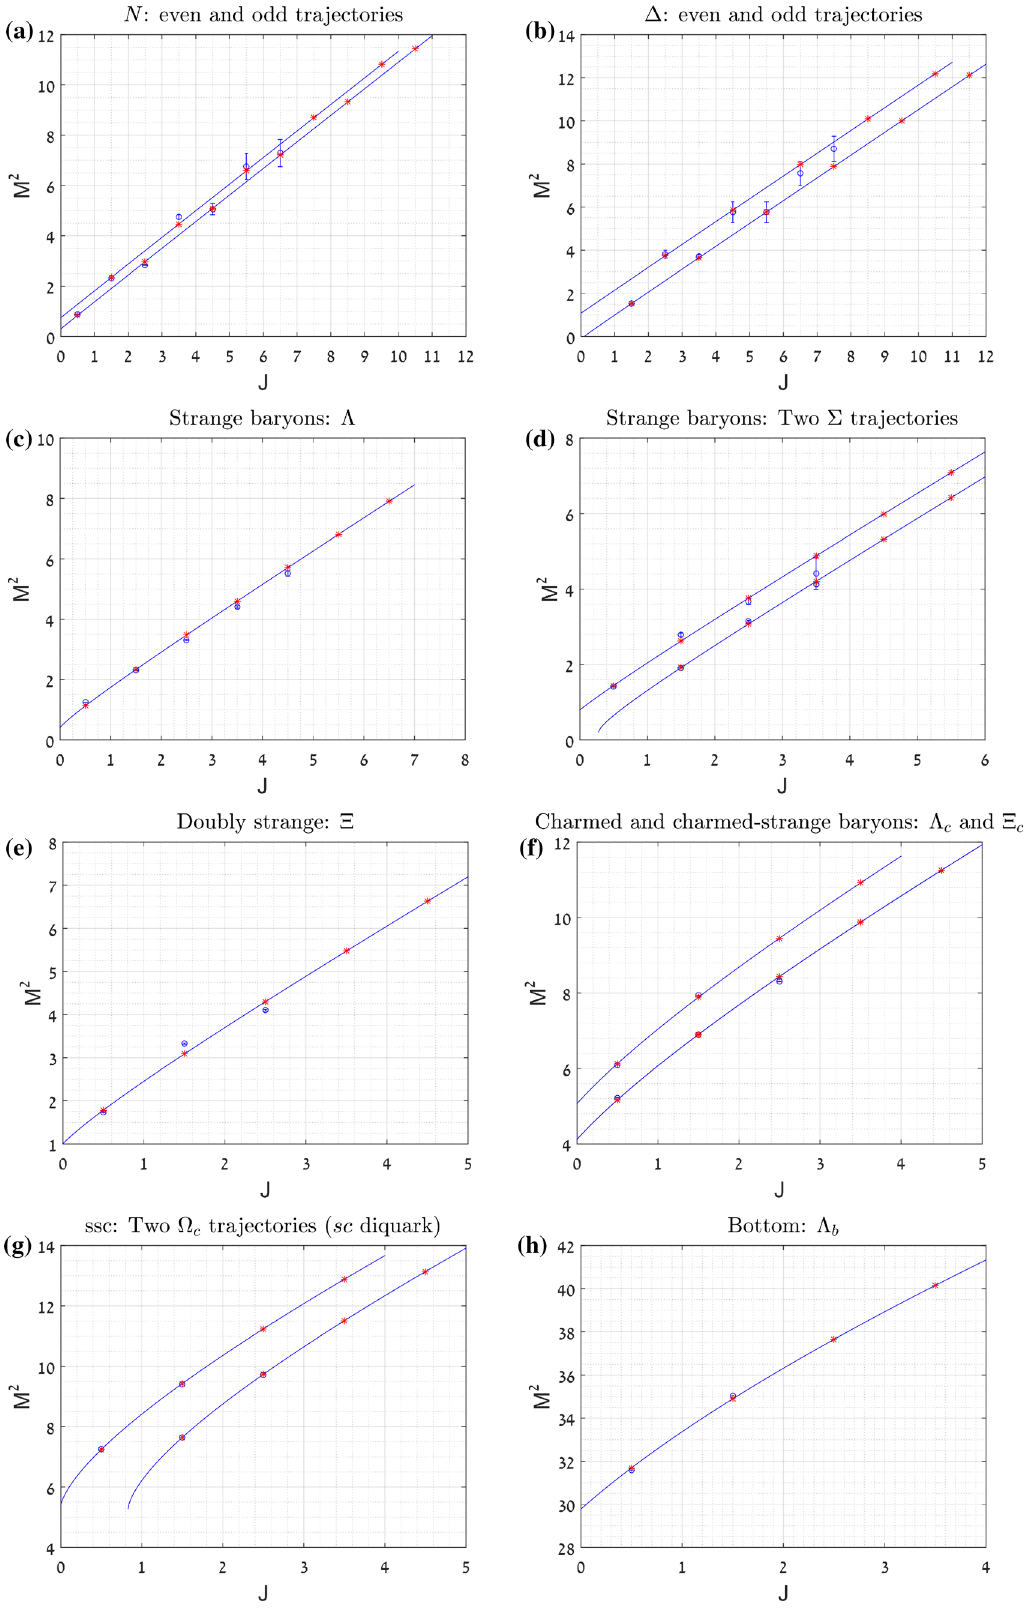
Fig. 6 The leading orbital trajectories of the baryons fitted with the common slope α (cid:2) = 0 . 95 GeV − 2 . All the states fitted are listed in the appendix in Table